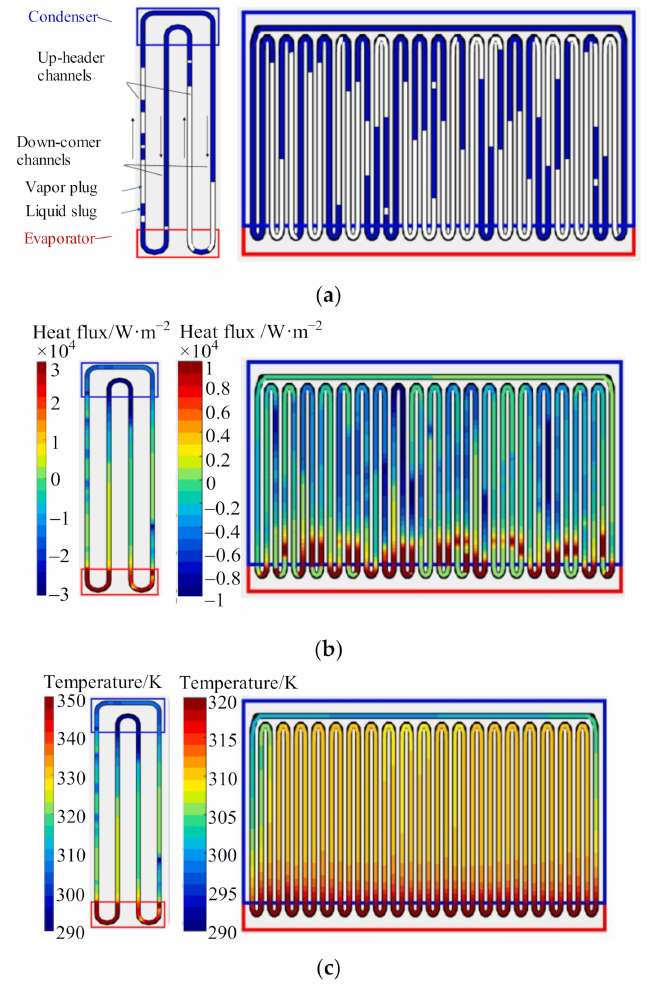
Figure 14. Heat pipe visualization data graph [209]. Noh et al., (2020). ( a ) Distribution of liquid slug and vapor plug. ( b ) Heat flux distribution. ( c ) Wall temperature